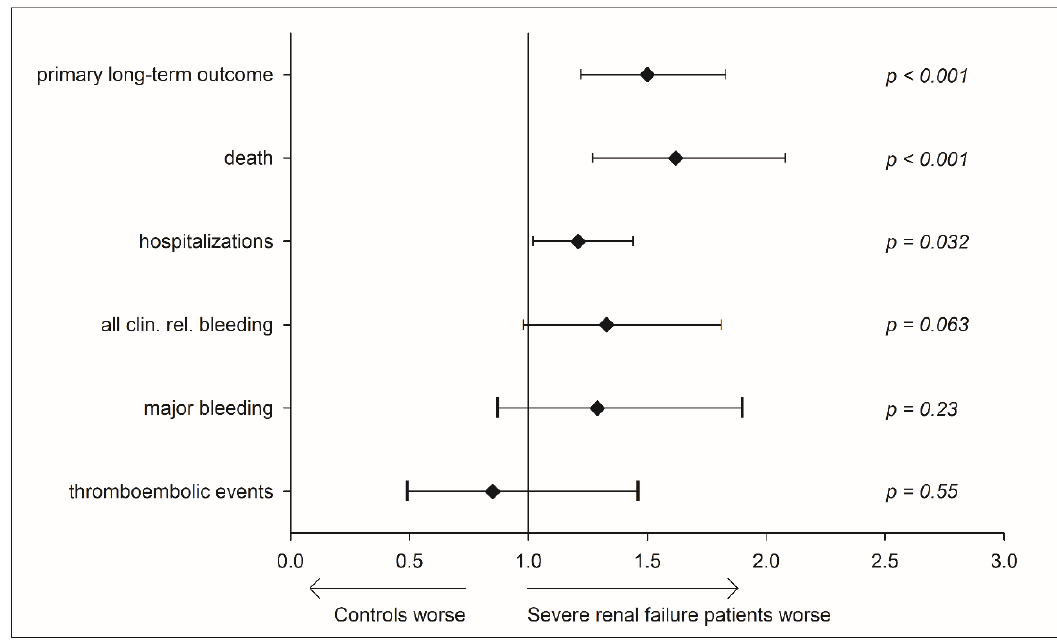
Figure 1. Adjusted safety endpoints and outcome measures comparing severe renal failure patients and controls in usual medical care, Cox regression. Forest plot showing the rate ratios and 95% confidence intervals of endpoints; primary long-term outcome: composite endpoint of clinically-relevant non-major and major bleeding, myocardial infarction, systemic and pulmonary embolism, stroke, and death. Adjusted for age, sex, diabetes, dyslipidemia, hypertension, obesity, family history of myocardial infarction, smoking, atrial fibrillation, congestive heart failure, coronary artery disease, previous myocardial infarction, deep vein thrombosis, pulmonary embolism, and liver disease. Compared to controls, individuals with severe renal failure experienced a 50% elevated risk for